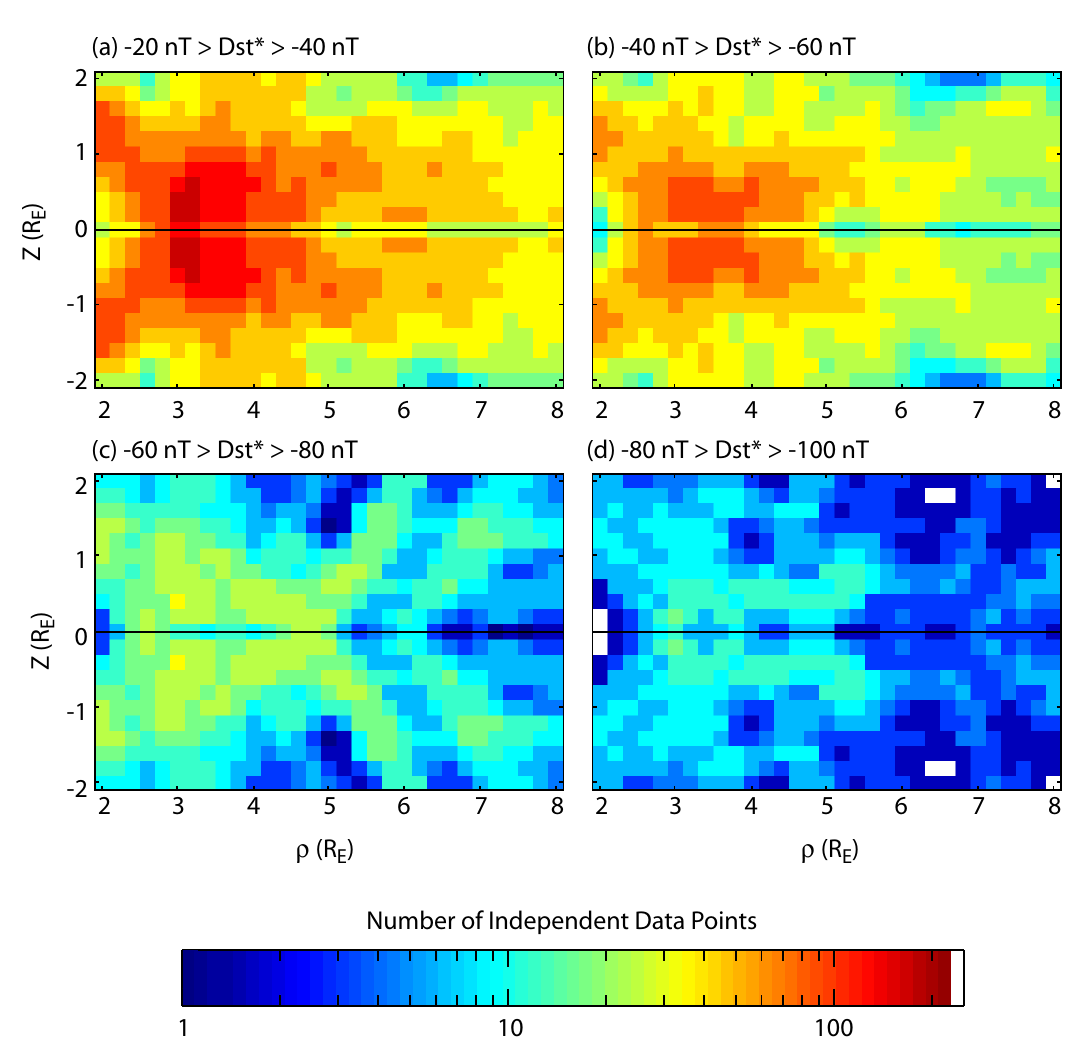
Fig. 3. Data coverage in the midnight plane for the four ranges of D st * used in this study.